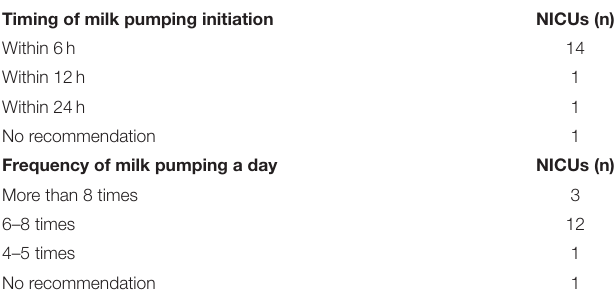
TABLE 4 | Timing of milk pumping initiation.